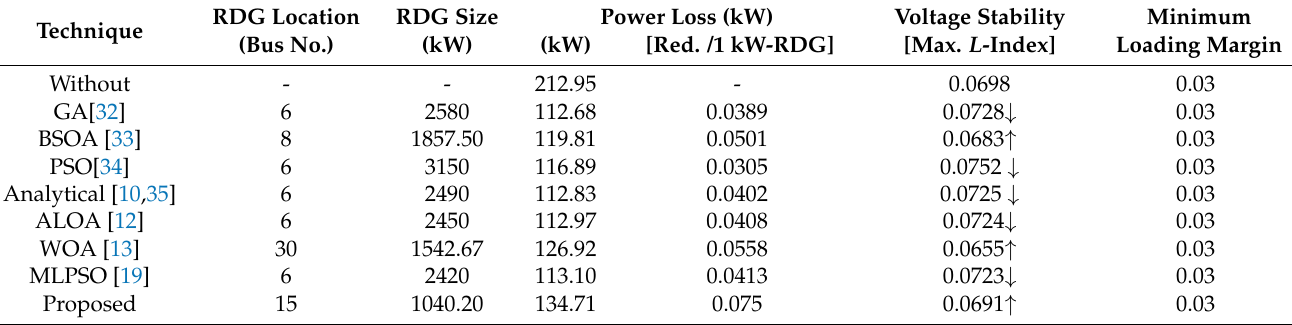
Table 6. Comparison results of optimal locations and sizes for installing one RDG of IEEE 33-bus distribution test system ( ↑ :improvement of voltage stability; ↓ degradation of voltage stability; red.: power loss reduction).